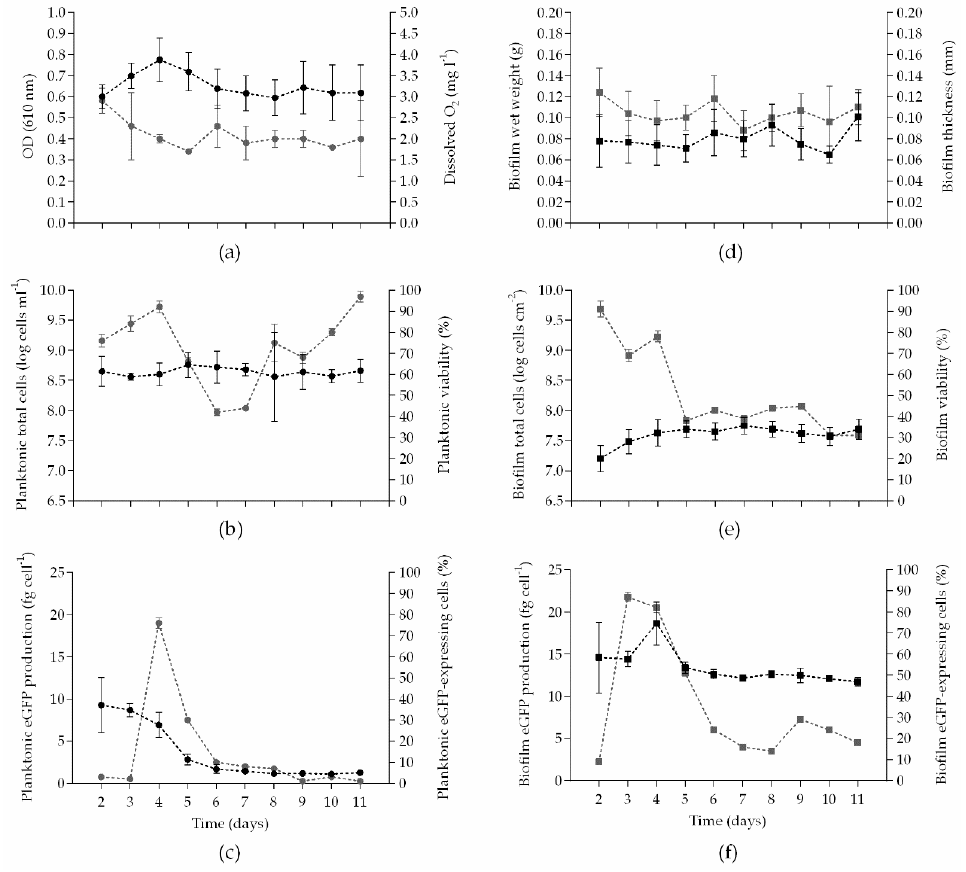
Figure 1. Time-course evolution of planktonic and biofilm parameters: ( a ) OD 610 nm and dissolved oxygen in the recirculating tank; ( b ) planktonic total cells and planktonic viability; ( c ) planktonic eGFP production and percentage of planktonic eGFP-expressing cells; ( d ) biofilm wet weight and thickness; ( e ) biofilm total cells and biofilm viability; ( f ) biofilm eGFP production and percentage of biofilm eGFP-expressing cells. Black circles (●) and squares ( ■ ) on the left y-axis, and grey circles (●) and squares ( ■ ) on the right y-axis. The means ± SDs for three independent experiments are illustrated.